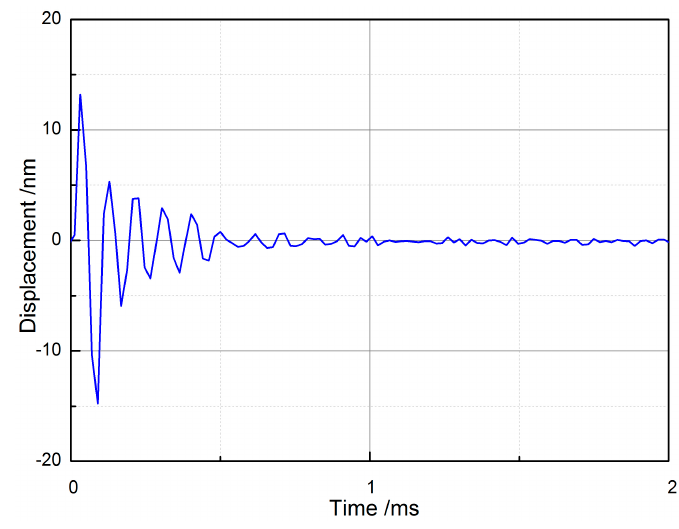
Figure 6. Pulse response of the piezoelectric transducer.